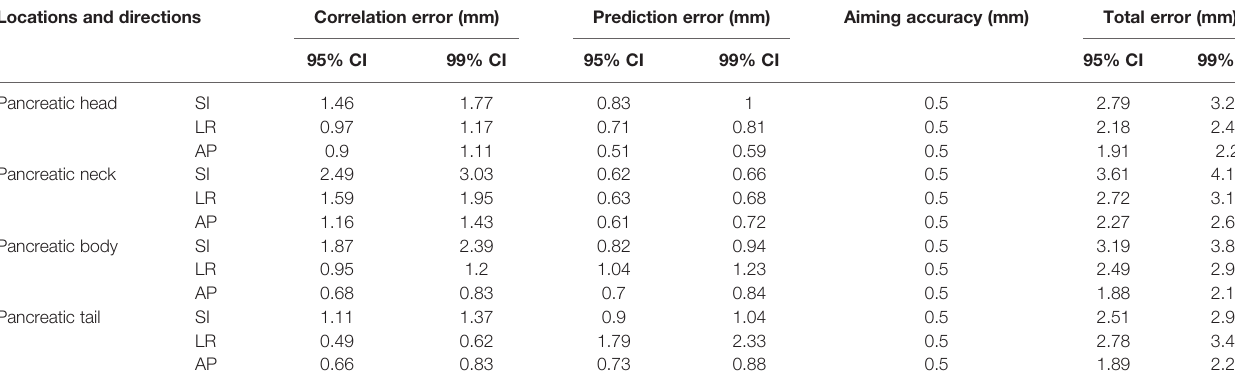
TABLE 3 | Statistics of correlation, prediction, and total errors of pancreatic tumors at different anatomical locations. Locations and